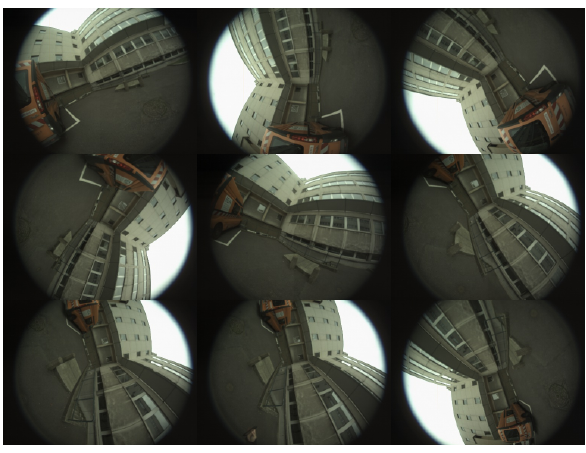
Figure 15. Photos of a static scene with different viewing positions for MicMac